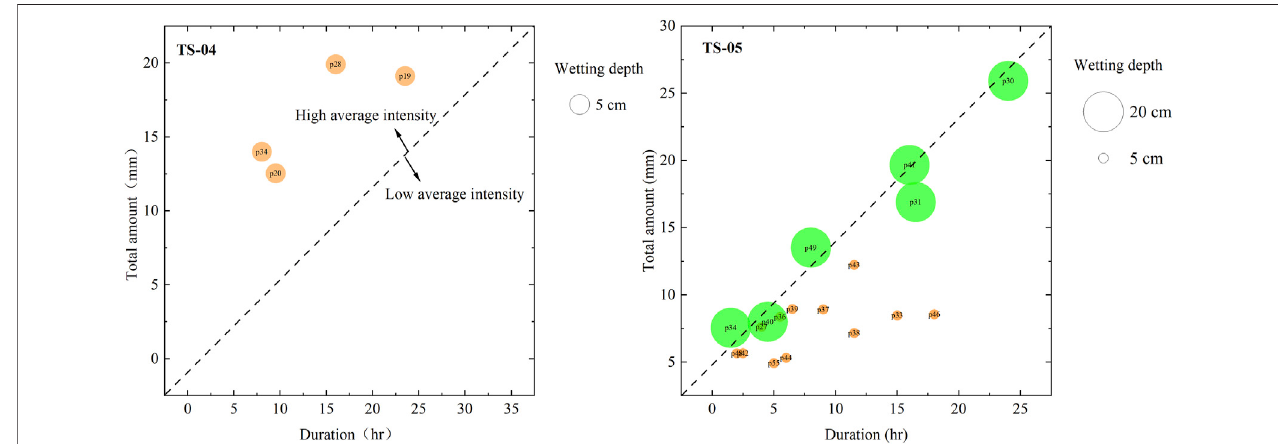
FIGURE 11 | Depth of soil moisture response to rainfall at TS-04 and TS-05 sites.